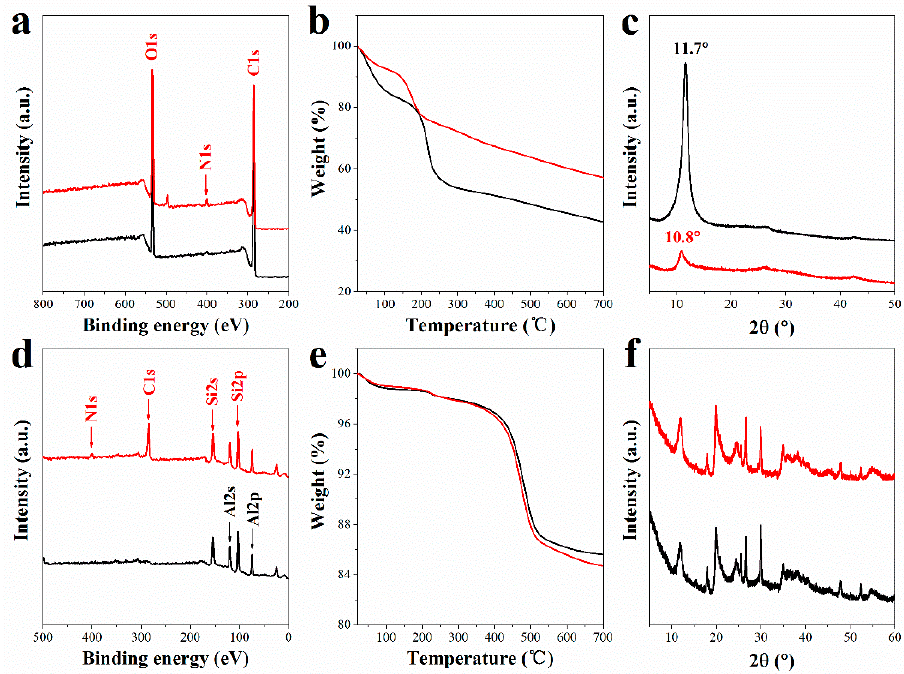
Figure 1. ( a ) XPS, ( b ) TGA, and ( c ) XRD curves of GO (black line) and DGO (red line). ( d ) XPS, ( e ) TGA, and ( f ) XRD curves of HNTs (black line) and DHNTs (red line).